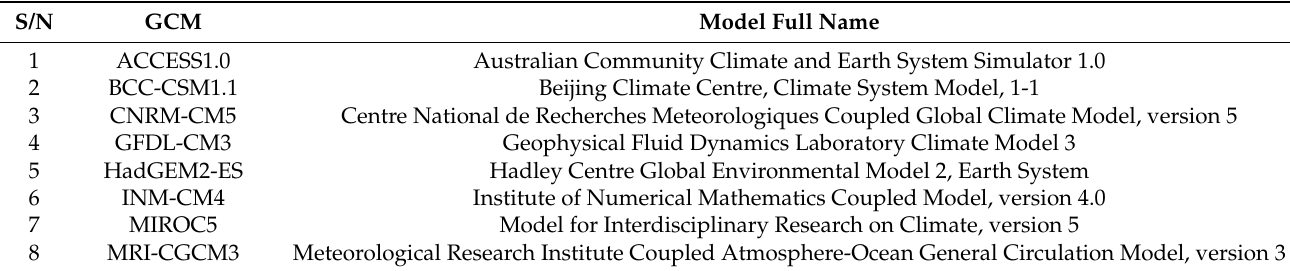
Table 1. CMIP5 GCMs from CSIRO-COWCLIP2.0 used for this